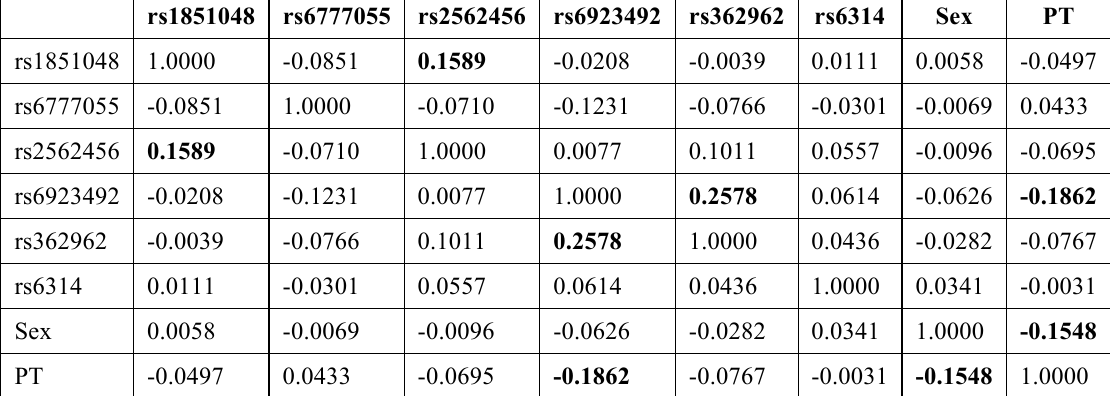
Table 5: The matrix of Spearman correlation coefficient values for studied SNPs, sex and